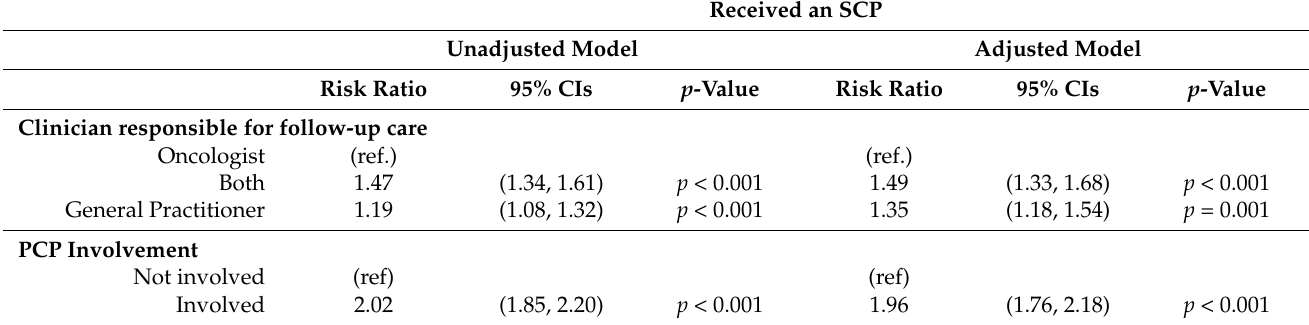
Table 3. Multinomial and Binomial Logistic Regression Analysis for SCPs and Patient Reported Satisfaction